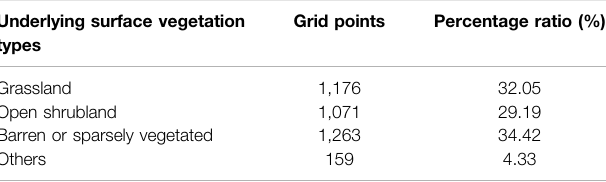
TABLE 1 | The grid points and percentages of the main types of underlying surfaces in Qinghai-Tibet Plateau. Underlying surface vegetation types